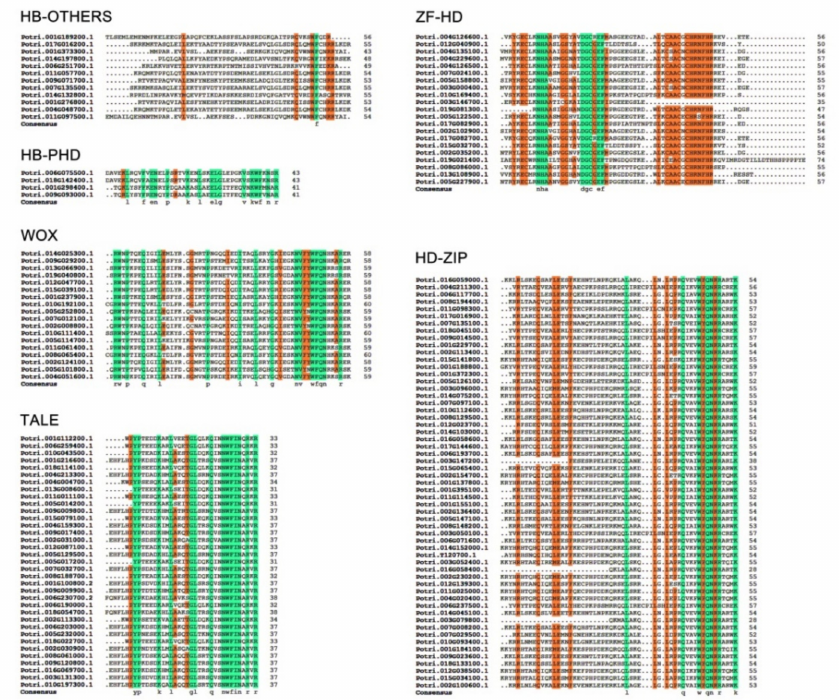
Figure 2. Multiple sequence alignment of conserved HD domains in the ZF-HD, HD-ZIP, WOX, TALE, HB-PHD and HB-OTHERS subfamilies. The colored boxes indicate conserved amino acid